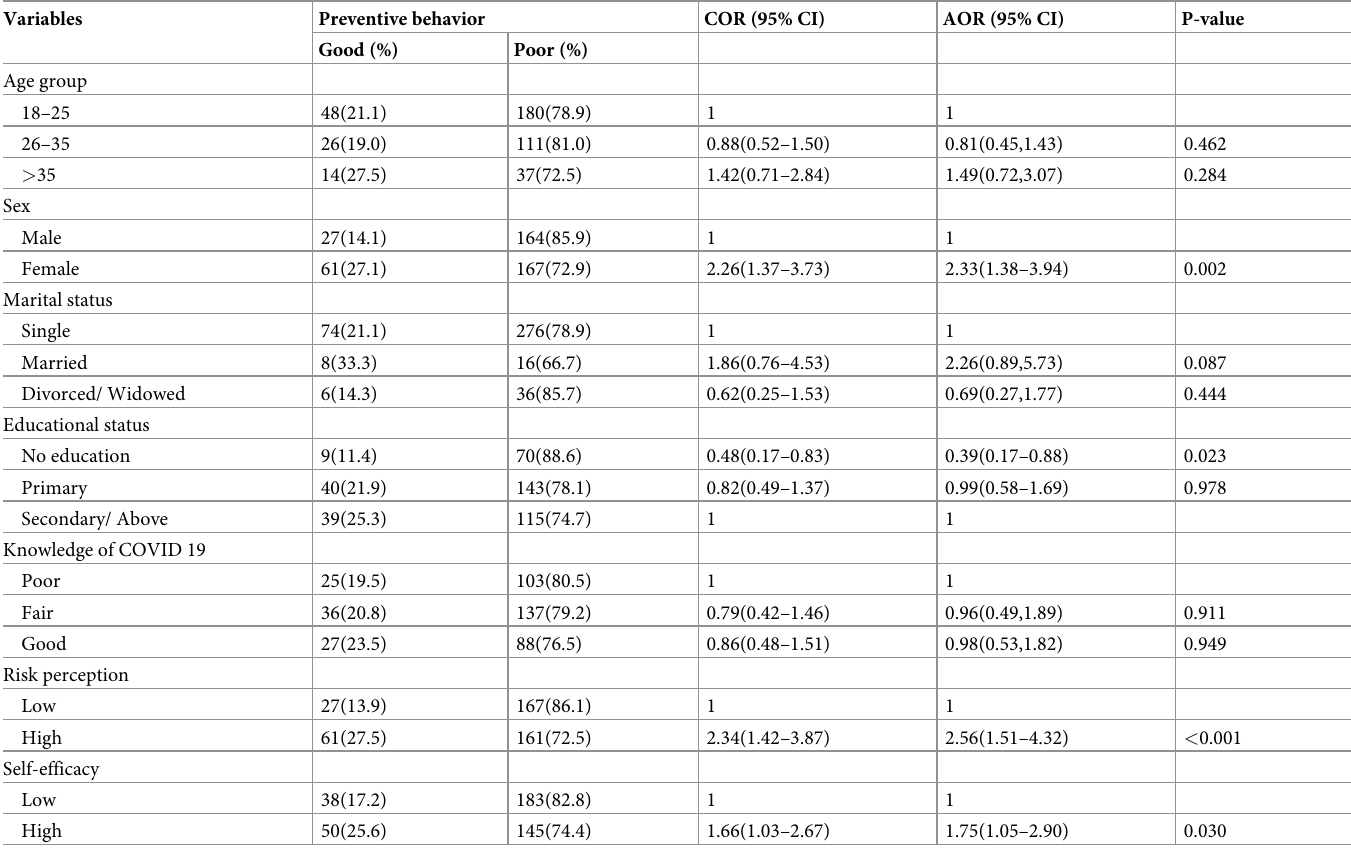
Table 4. Factors associated with COVID 19 preventive behavior among waiters working in food and drinking establishments, Southwest Ethiopia,